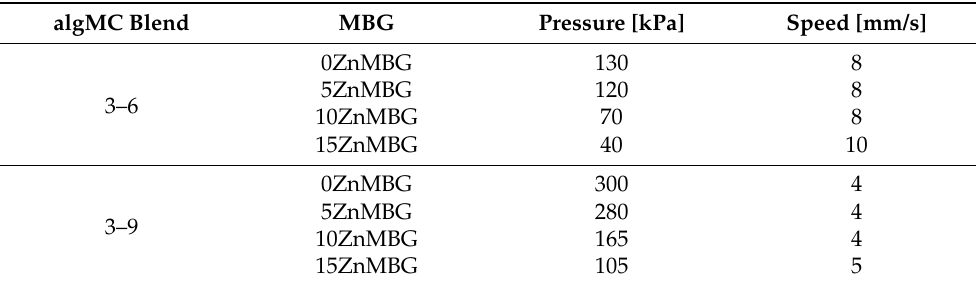
Table 3. Three-dimensional printing parameters of composite bioinks containing 7% of MBG and hTERT-MSC